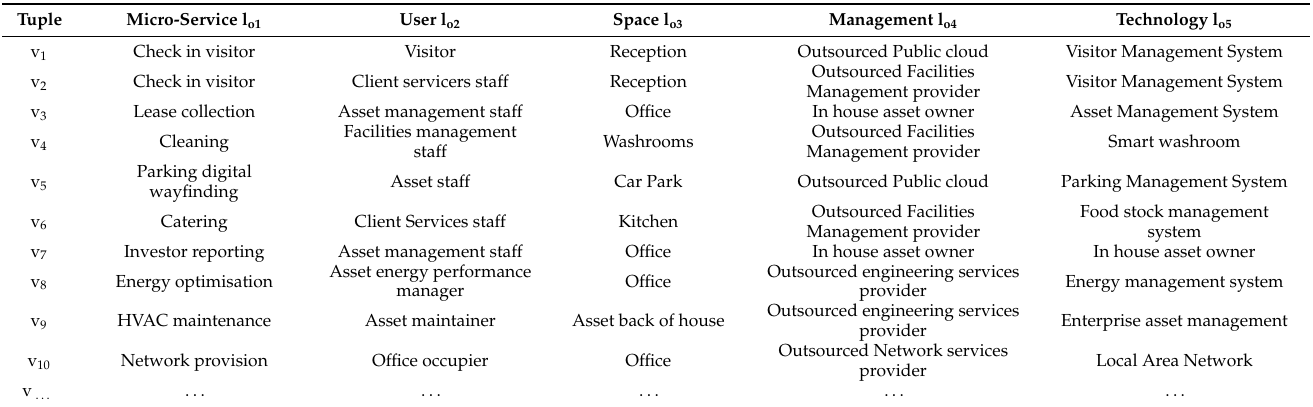
Table 1. Asset Omni-management